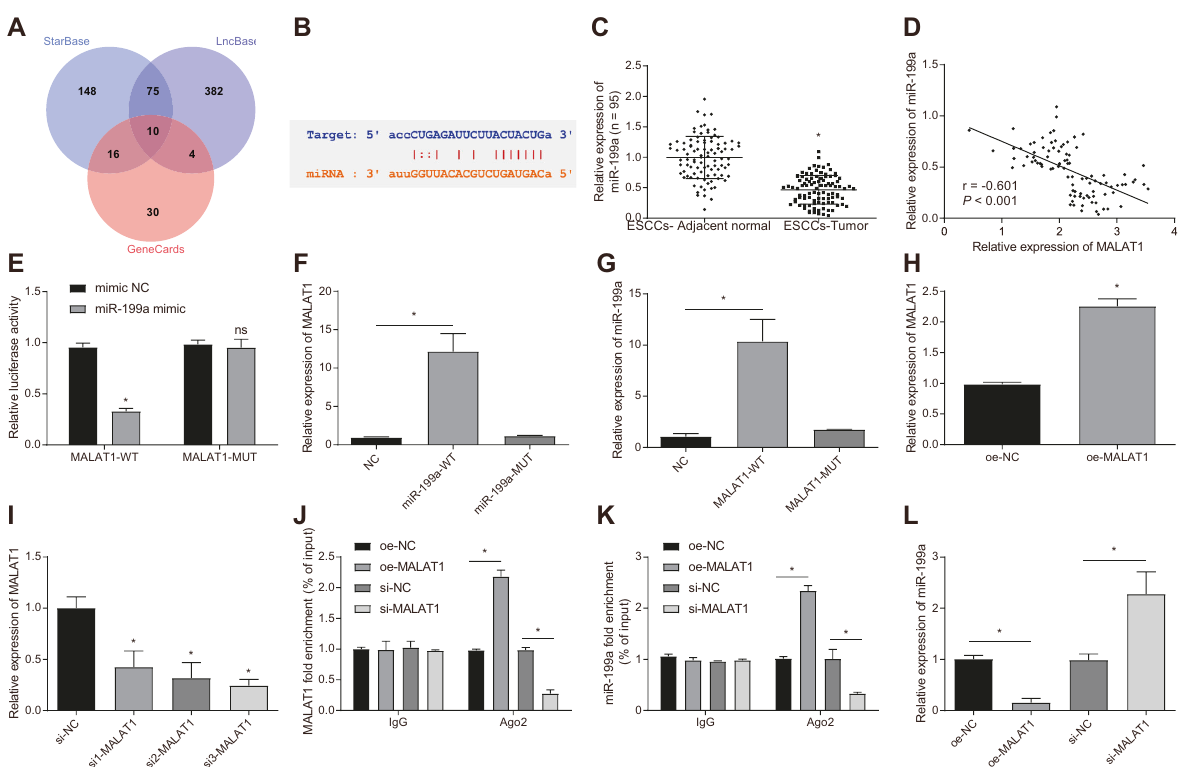
Fig. 4 MALAT1 competitively bound to miR-199a in ESCC cells. A Venn diagram of downstream miRs of MALAT1 predicted by starBase and LncBase databases and the ESCC-related miRs obtained from the GeneCards database. B The binding site of MALAT1 and miR-199a predicted by starBase website. C The expression of miR-199a in tumor tissues (ESCCs-Tumor group) and adjacent normal tissues (ESCCs-Adjacent normal group) in ESCC patients, as detected by qRT-PCR. n = 95 in ESCC patients. D Correlation analysis of miR-199a expression and MALAT1 expression in tumor tissues of 95 ESCC patients analyzed by Pearson correlation analysis. E Dual luciferase report assay was adopted to examine the binding af fi nity between MALAT1 and miR-199a. F RNA-pull down assay was employed to detect the binding between biotin- labeled miR-199a-WT with MALAT1, and the binding between miR-199a-MUT with MALAT1. G RNA-pull down assay was employed to detect the af fi nity between the biotin-labeled MALAT1-WT and miR-199a, and the af fi nity between the MALAT1-MUT with miR-199a. H The expression of MALAT1 in KYSE150R cells was measured by qRT-PCR in oe-NC group and oe-MALAT1 group. I qRT-PCR was employed to detect the transfection ef fi ciency of si-MALAT1 in KYSE150R cells. J RIP experiment was employed to assess the enrichment of MALAT1 in Ago2 in KYSE150R cells in response to oe-MALAT1 or si-MALAT1. K RIP experiment was employed to assess the enrichment of miR-199a in Ago2 in KYSE150R cells in response to oe-MALAT1 or si-MALAT1. L The expression of miR-199a was examined in KYSE150R cells in response to oe- MALAT1 or si-MALAT1 examined by qRT-PCR. * p < 0.05 compared with adjacent normal tissues, mimic-NC group, NC group, oe-NC group or si- NC group. ns, not signi fi cant. Measurement data were presented as mean ± standard deviation. Paired t test was employed to analyze the data of tumor tissues group and adjacent normal tissues group. The other two groups were compared by unpaired t test. One-way ANOVA with Tukey ’ s post-hoc test was employed to compare the data of multiple groups. Cell experiments were repeated in